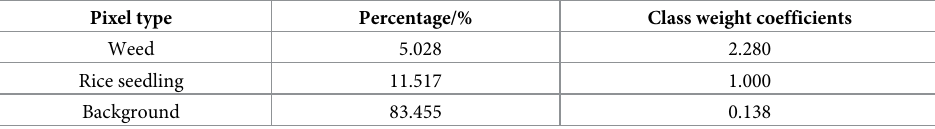
Table 1. Number of pixels with classes and the class weight